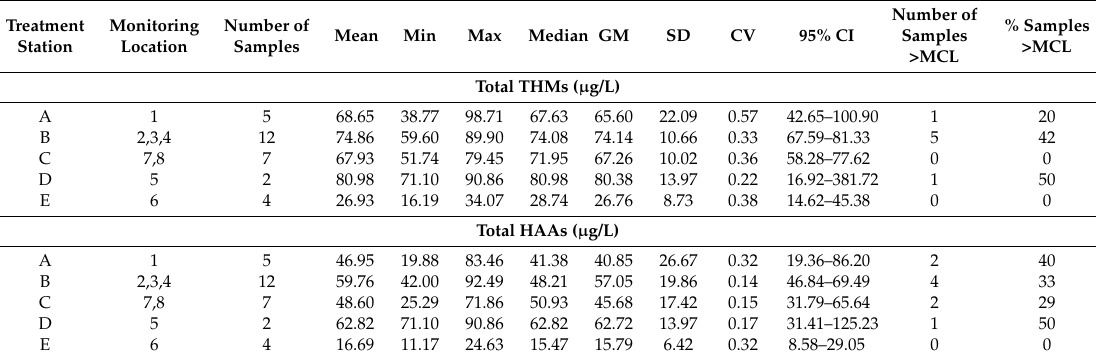
Table 3. Summary statistics of the residential monitoring data for total THMs and HAAs. Treatment